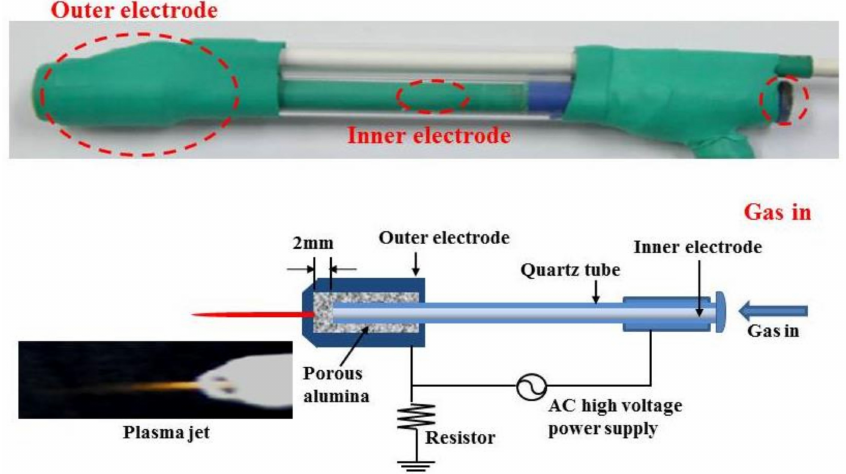
Figure 2. Schematic drawing of non-thermal atmospheric pressure plasma jet provided by